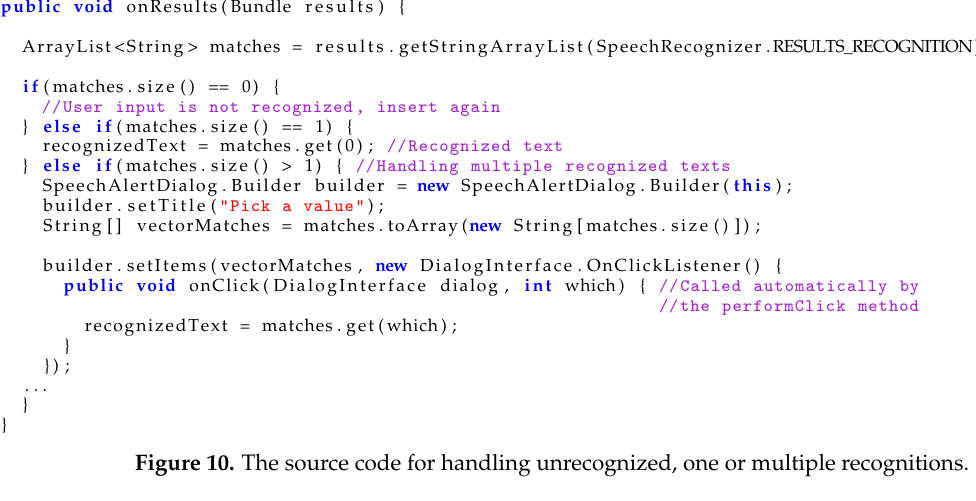
Figure 9. The source code of method speakSpeechLayout .